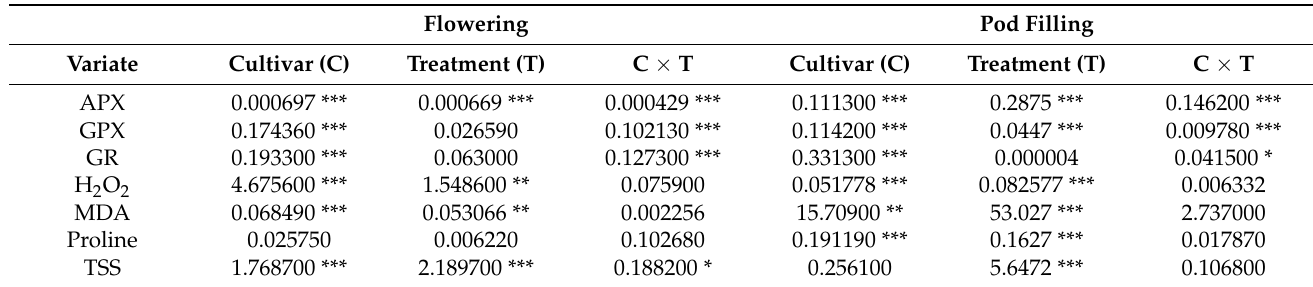
Table 1. Analysis of variance for the biochemical parameters of five vegetable-type soybean cultivars subjected to two water treatments at flowering and pod-filling